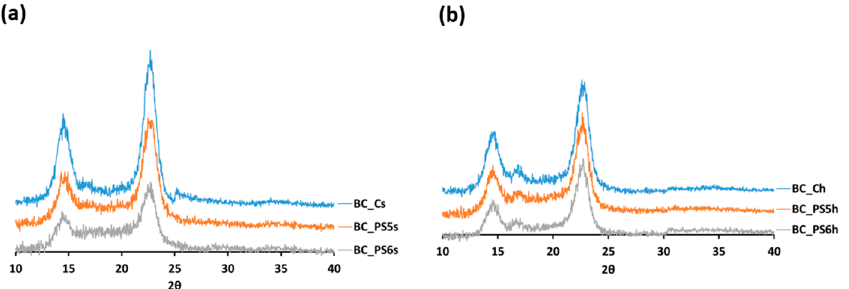
Figure 1. X-Ray diffraction patterns of ( a ) samples obtained from non-homogenized bacterial cellulose (BC), and ( b ) samples obtained from homogenized BC.